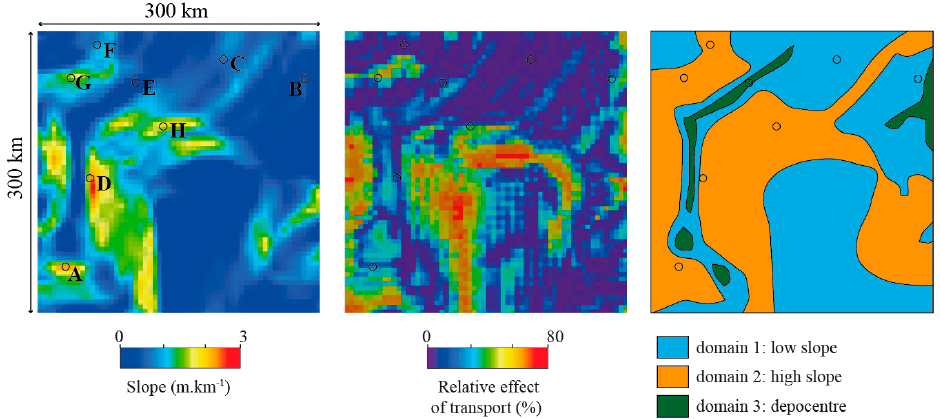
Figure 13. Slope map, relative effect of transport and domain of TOC distribution for the interval 3 (181.7 to 181.5 Ma).